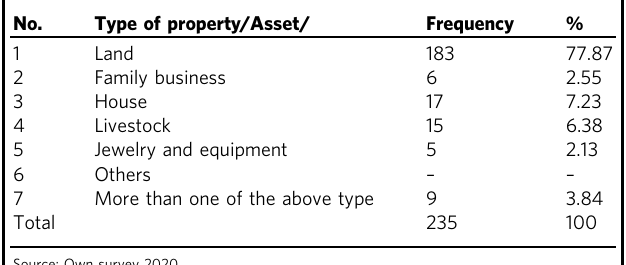
Table 2 Frequency distribution of family disputes by property